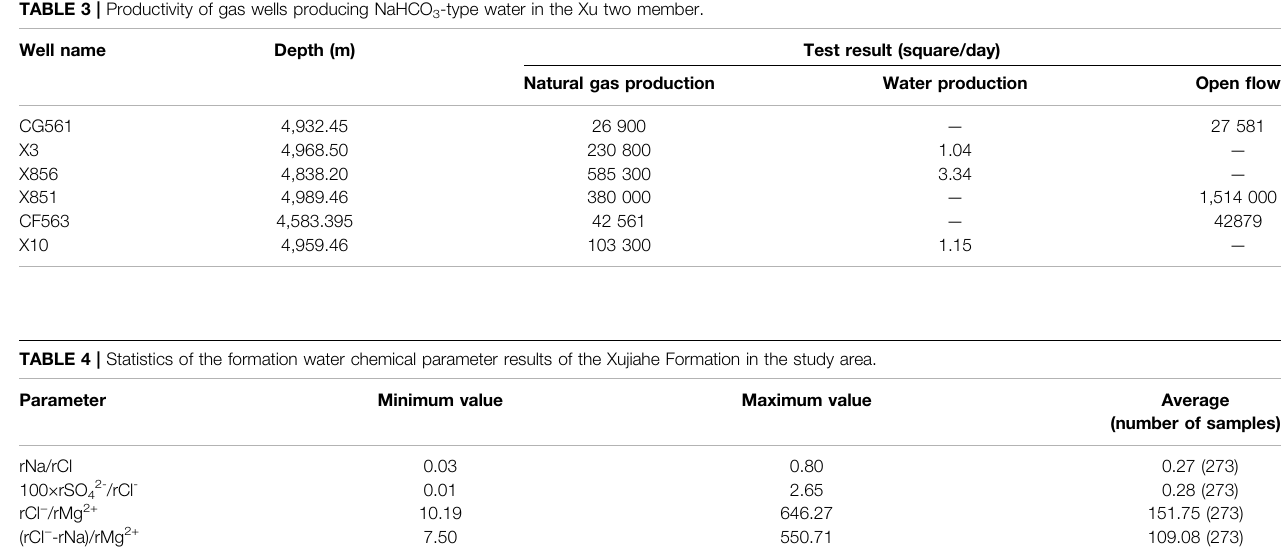
TABLE 3 | Productivity of gas wells producing NaHCO 3 -type water in the Xu two member.